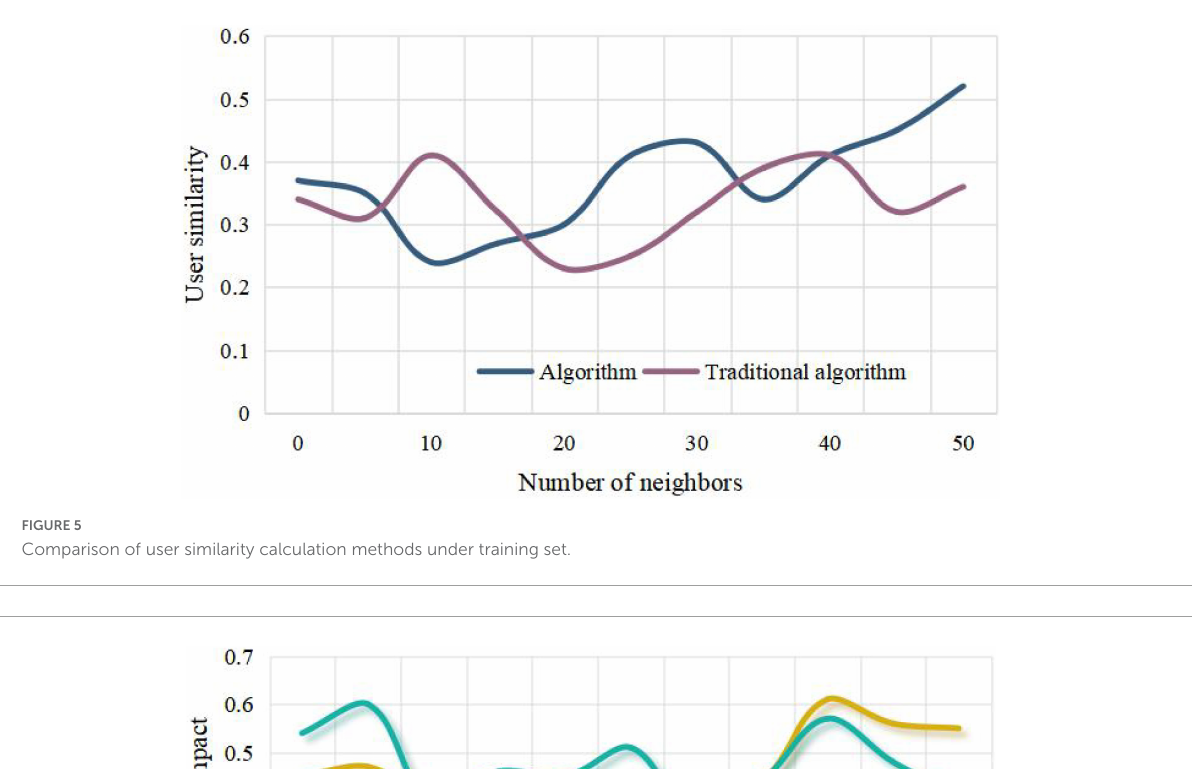
FIGURE5 Comparison of user similarity calculation methods under training set.